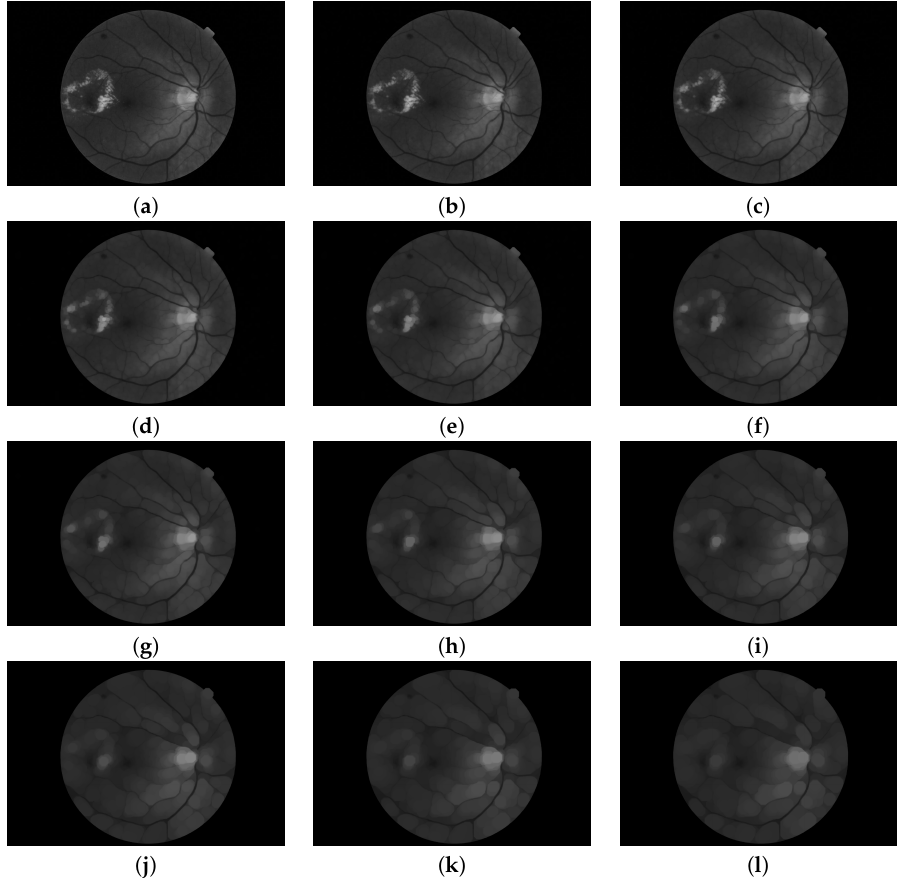
Figure 5. Pyramid of openings computed for a fundus image using an isotropic structuring element. It is composed by 12 images ( n = 0,2,4, . . . ,22). ( a ) Original image; i.e., γ 0 is the identity mapping; ( b–k ) are the results of applying the opening operator with increasing size (according to s = 2) and ( l ) is the last image of the pyramid corresponding to the operation γ nmax